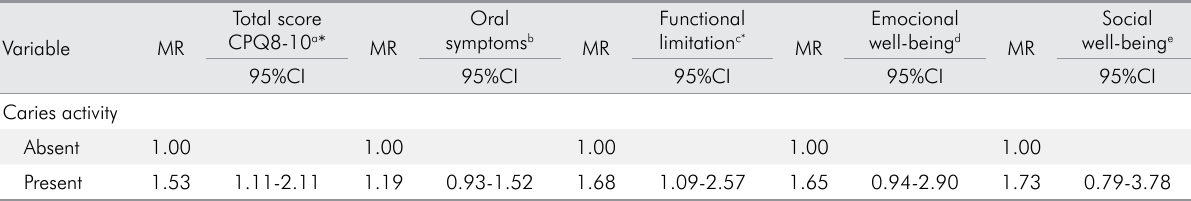
a Model adjusted for sex, age and number of siblings; b Model adjusted for sex, age, family income, caregiver education, trauma, malocclusion; c Model adjusted for sex and age; d Model adjusted for sex, age, number of siblings and caregiver education; e Model adjusted for sex, age, number of siblings, family income and